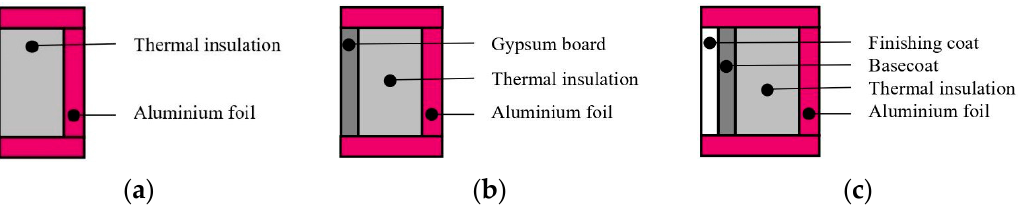
Figure 7. Section view of each analysed application: ( a ) thermal render; ( b ) thermal render with gypsum board; ( c ) multilayer system.